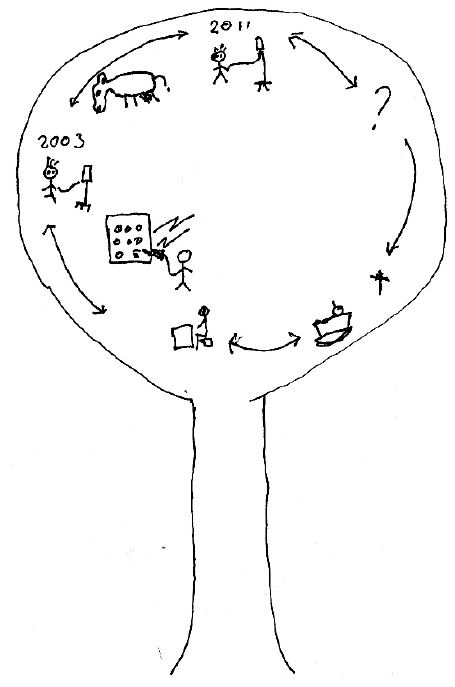
Figure 4. John’s drawing.